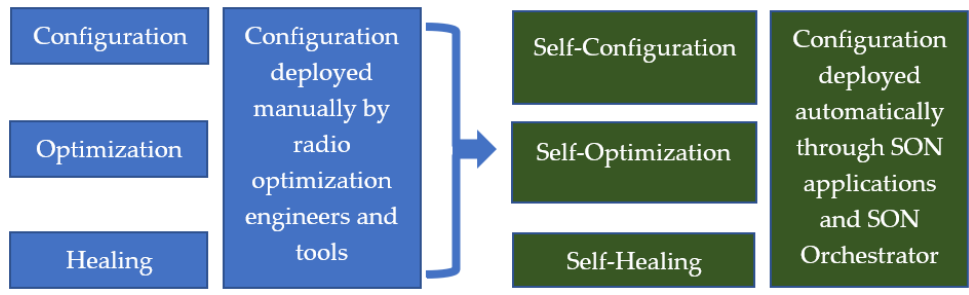
Figure 3. Replacing manual operations with SON.